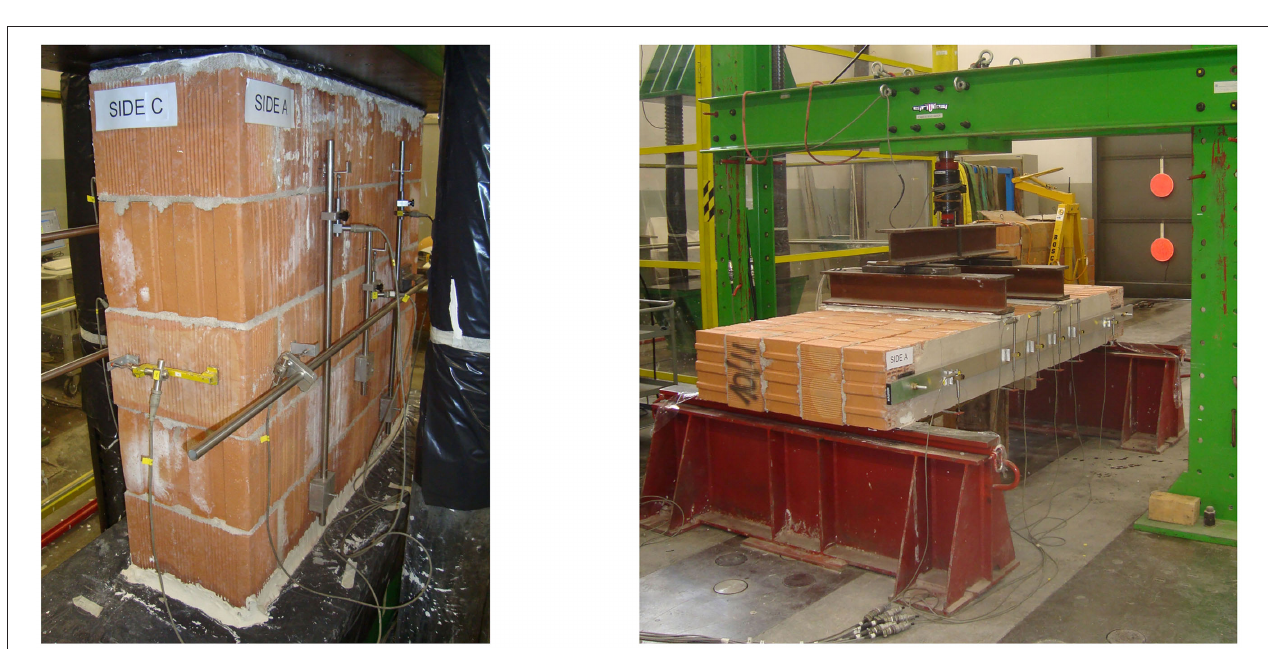
Frontiers in Built Environment |